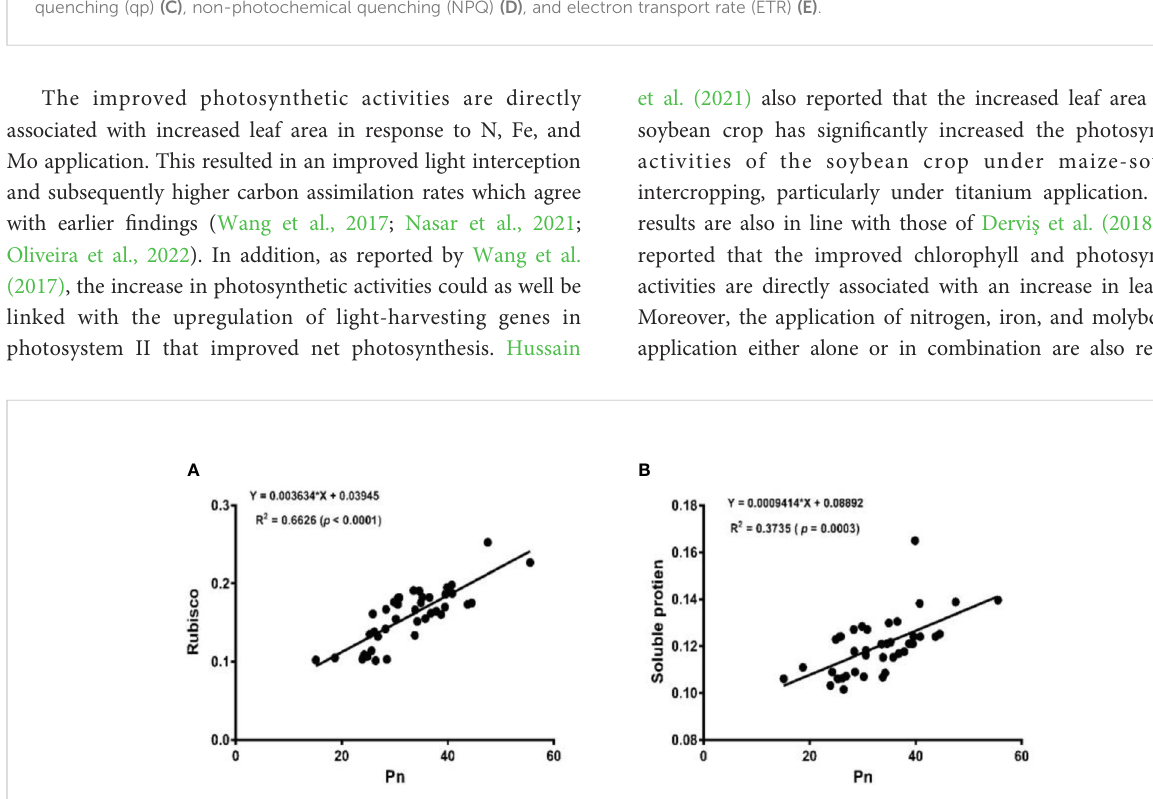
FIGURE 9 Linear regression of Pn with Rubisco activity (A) and soluble protein (B) of soybean